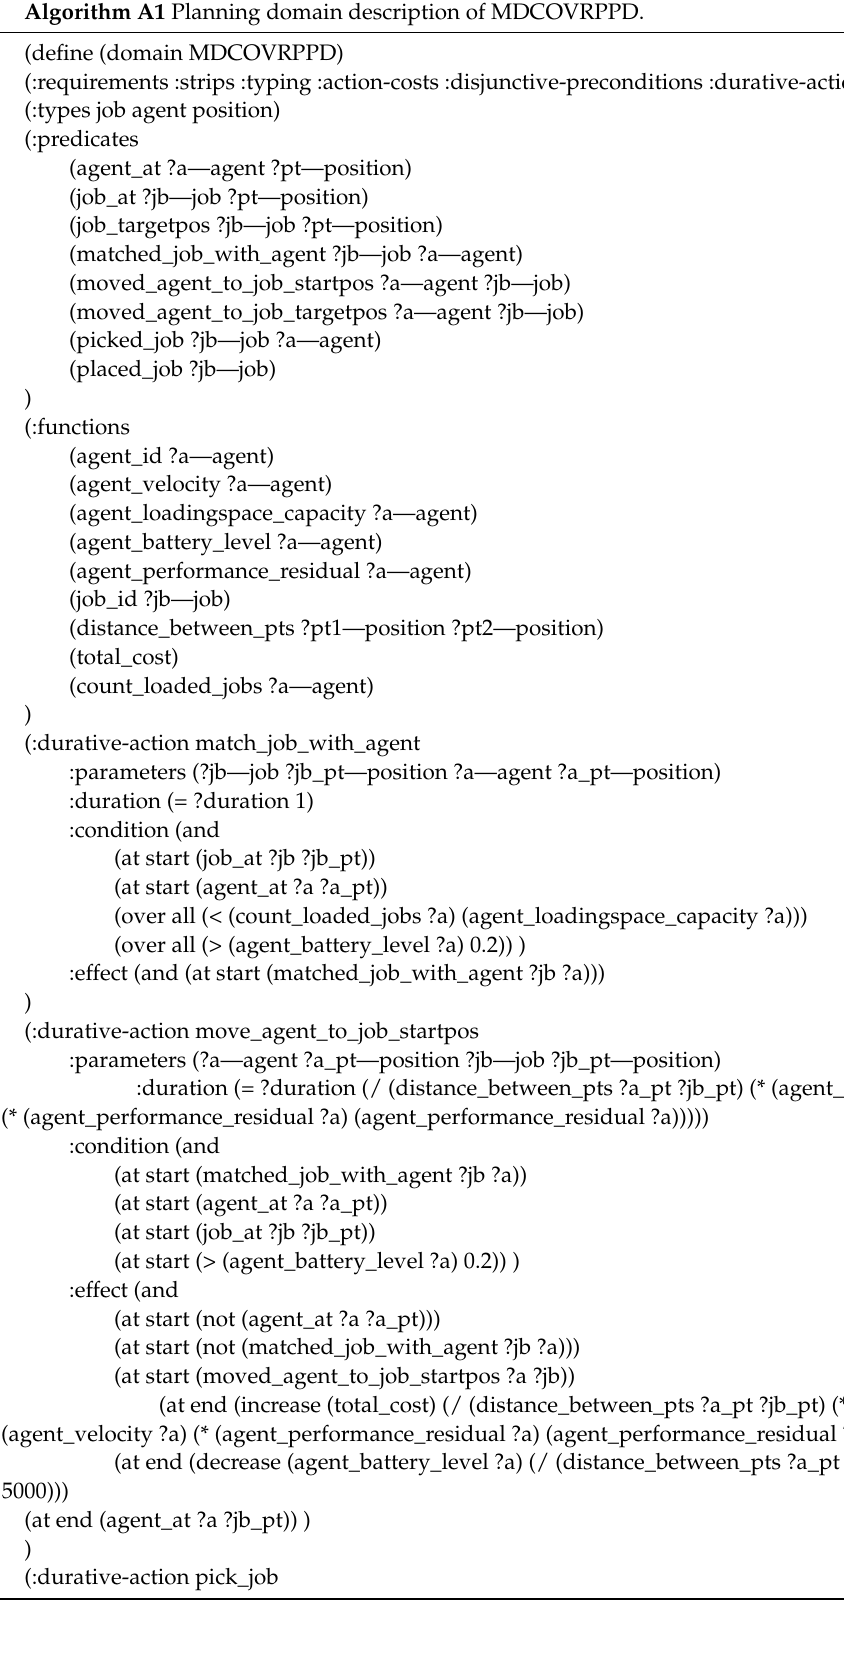
Algorithm A1 Planning domain description of